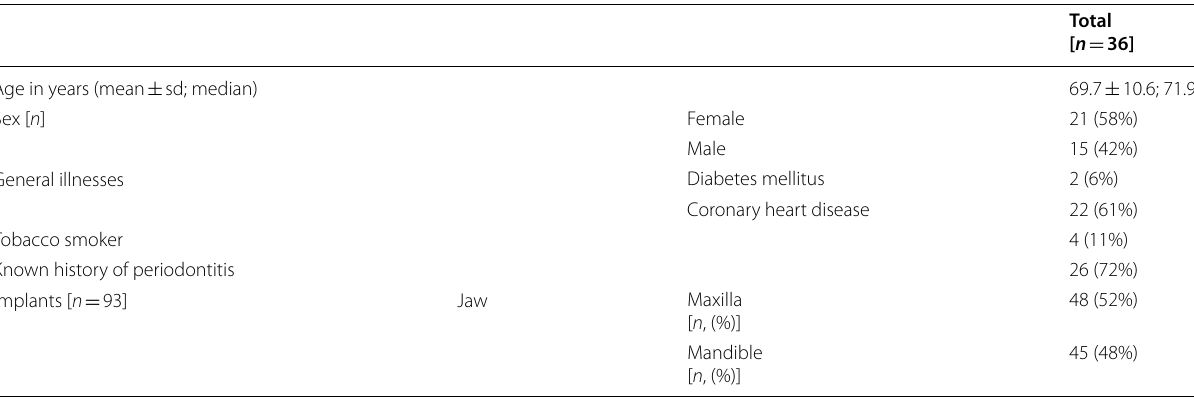
Table 1 Characteristics of the investigated patients